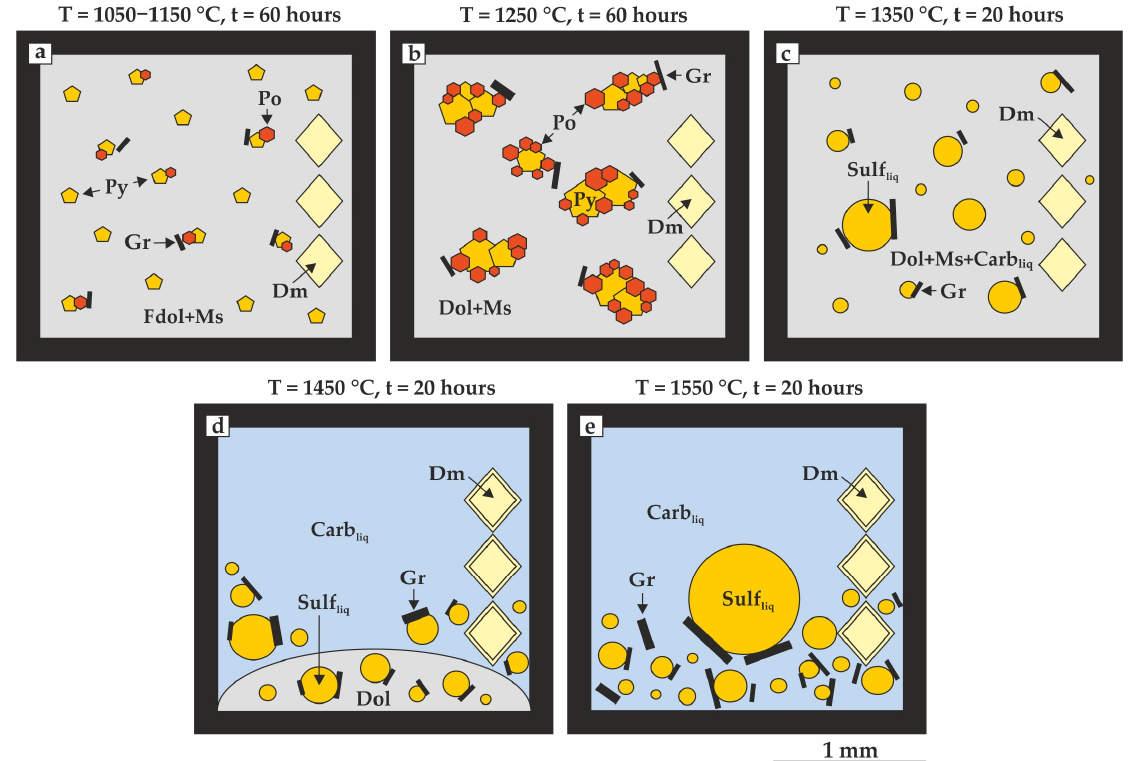
Figure 5. Schemes of samples produced in the ankerite-pyrite system at 6.3 GPa in temperature range of 1050–1550 ◦ C; Po—pyrrhotite; Py—pyrite; Dol—dolomite; Ms—magnesite; Carb liq —carbonate melt; Sulf liq —sulfide melt; Gr—graphite; Dm—diamond seed crystals. ( a ) scheme for 1050–1150 ◦ C, ( b ) scheme for 1250 ◦ C, ( c ) scheme for 1350 ◦ C, ( d ) scheme for 1450 ◦ C ( e ) scheme for 1550 ◦ C.